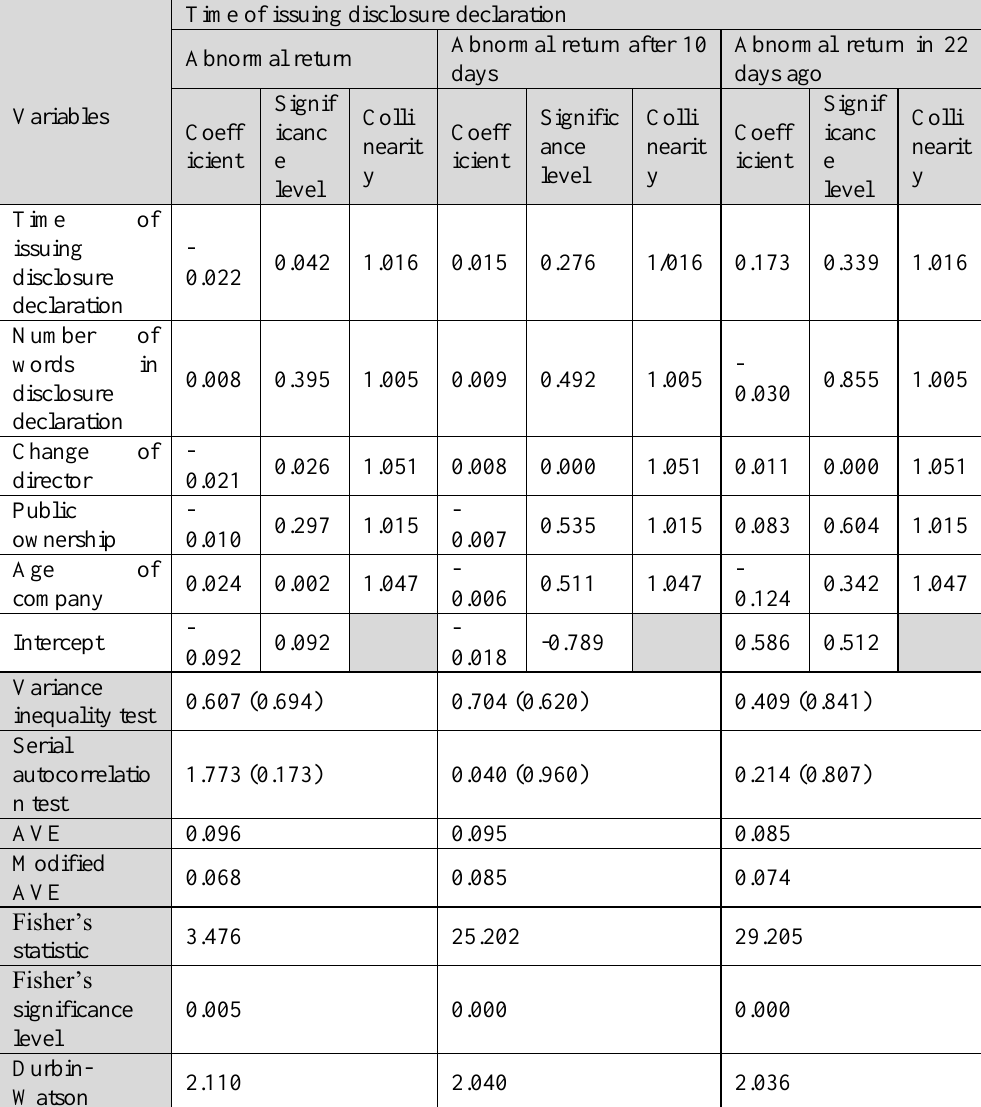
Table 10. Final estimation of the regressive model in fourth major